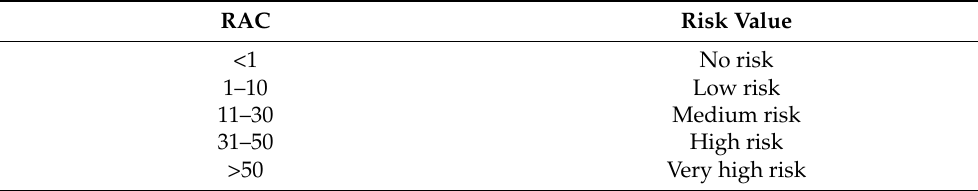
Table 4. Classification of RAC [29–31].